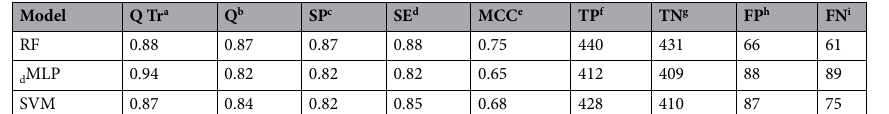
Table 5. Evaluation of alternative ML algorithms for the prediction of UV–Vis absorption spectrum class using 250 selected RDKitMorganFP molecular attributes. a Overall predictive accuracy for the training set in OOB estimation. b Overall predictive accuracy (test set I). c Specificity (test set I). d Sensitivity (test set I). e MCC, Matthews correlation coefficient (test set I). f True Positives (test set I). g True Negatives (test set I). h False Positives (test set I). i False Negatives (test set